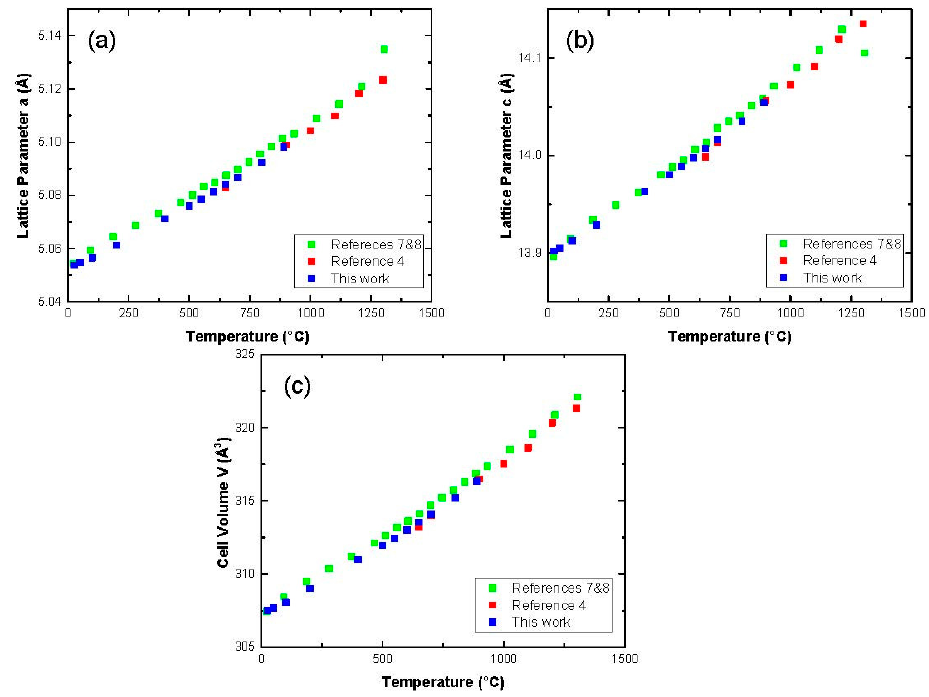
Figure 3. ( a ) Lattice parameter a, ( b ) lattice parameter c and ( c ) cell volume versus temperature for MgTiO 3 from present GQ and previous samples HT diffraction. Data taken from this work and [4,7,8].